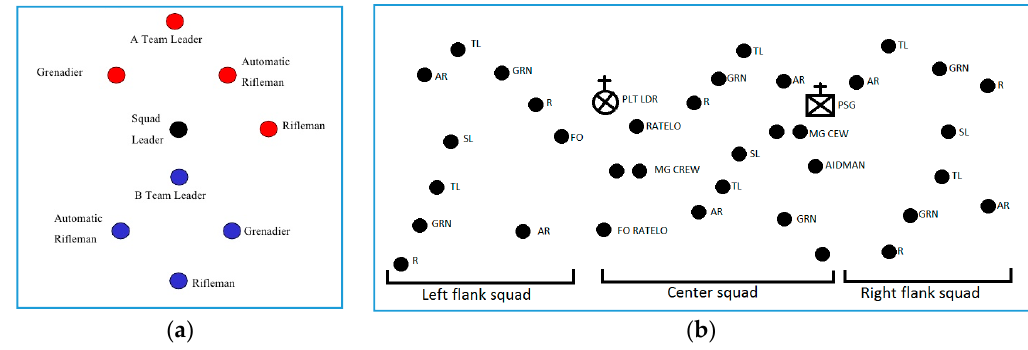
Figure 4. WMN small-scale military operations scenarios: ( a ) Squad line formation, in which a small number of nodes could be used to support a military operation; ( b ) infantry platoon formation, where three squads’ communication could be facilitated by WMNs to support a military operation.